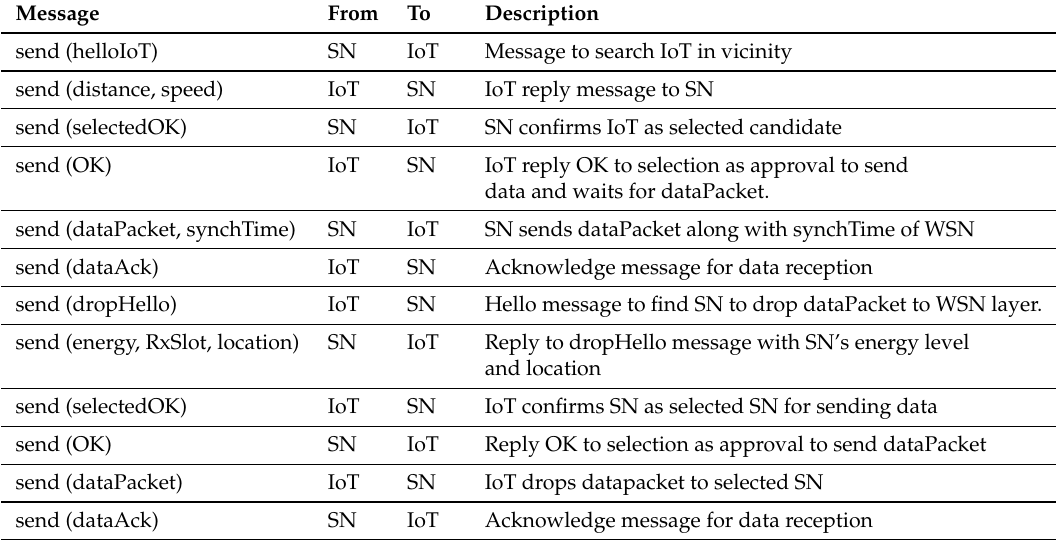
Table 1. List of messages exchanged by elements of integration platform (IT)